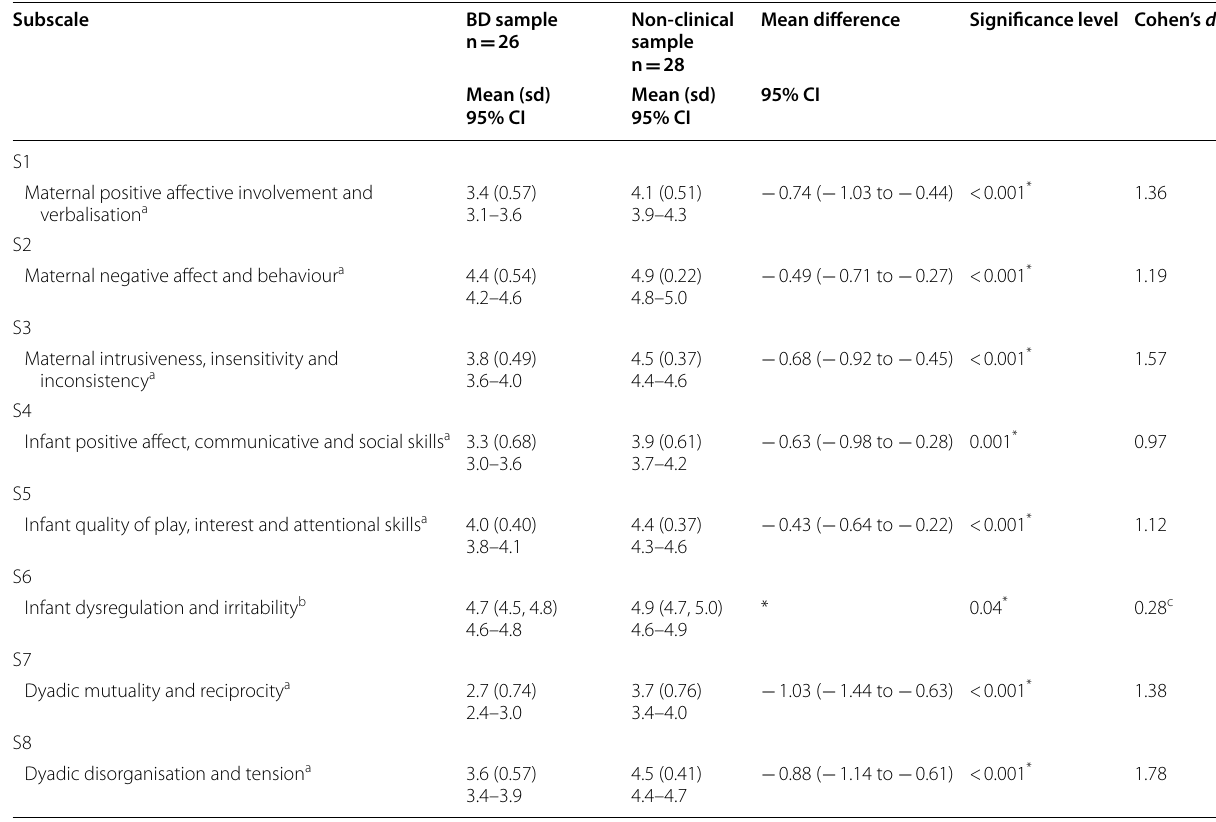
Table 2 Interaction score comparisons (mean) between the BD and the non-clinical sample on PCERA subscales at 12